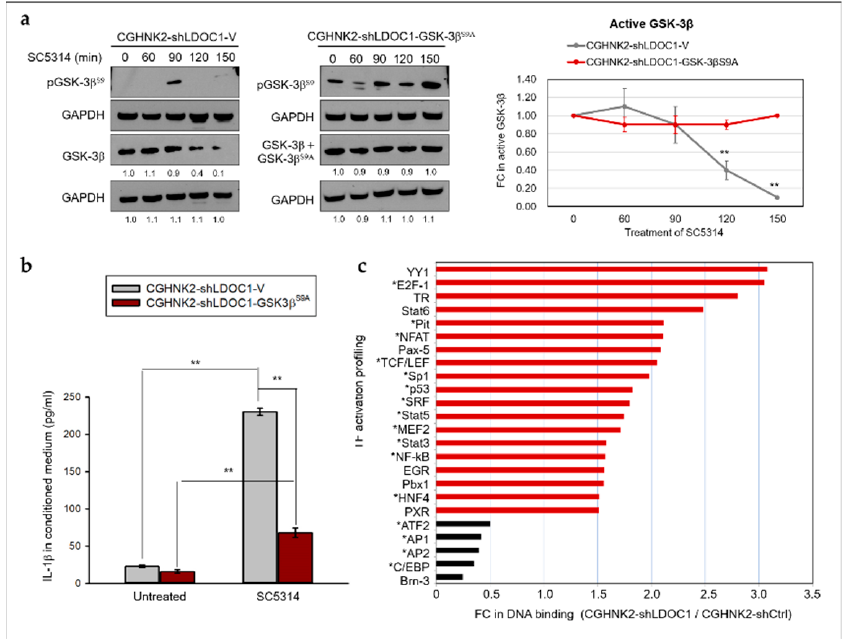
Figure 7. GSK-3 β participates in the enhanced IL-1 β production in LDOC1 -deficient CGHNK2- shLDOC1 cells after coculture with CA SC5314. ( a ) Western blotting analyses of the quantities of active GSK-3 β , GSK-3 β S9A , and inactive pGSK-3 β S9 proteins in CGHNK2-shLDOC1-V (left panel) and CGHNK2-shLDOC1-GSK-3 β S9A (center panel) cell lines. Densitometric analyses were performed